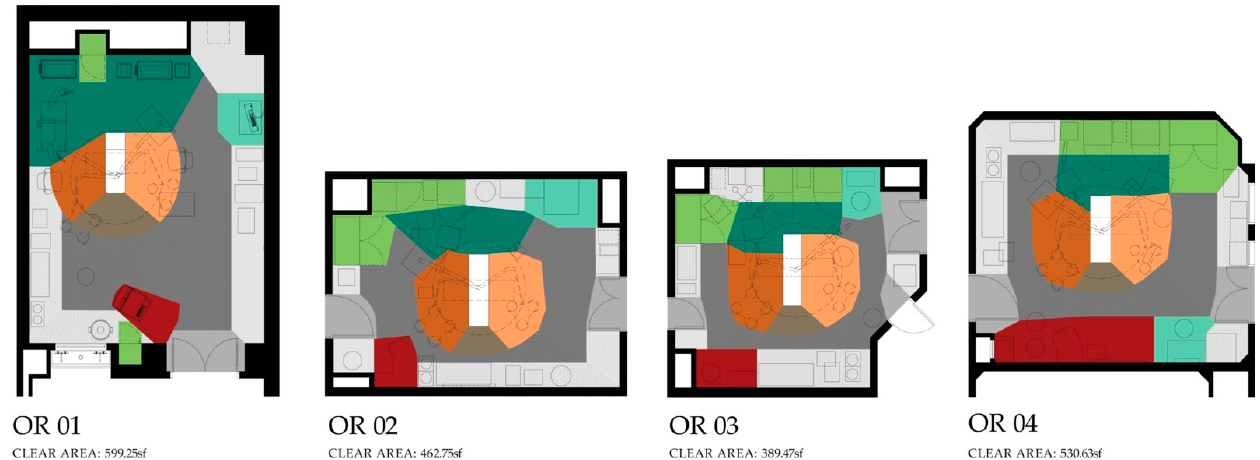
Figure 3. Floor plans of the four ORs observed with zones demarcated (refer to Figure 2 for legend). All floor plans are shown with surgical tables in orientation B.